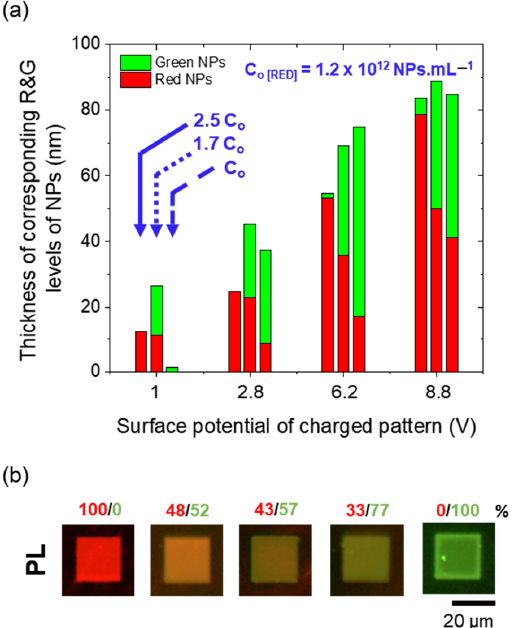
Figure 4. ( a ) Evolution of the thicknesses of the red and green NP levels forming vertical combinatorial patterns as a function of the initial surface potential of the charged pattern and the concentration of the red NP dispersion. ( b ) PL images of five red and green NP combinatorial 20 µm square patterns. The different compositions of each NP combinatorial pattern (stated in percentages of the total NP pattern thickness) lead to different colors.